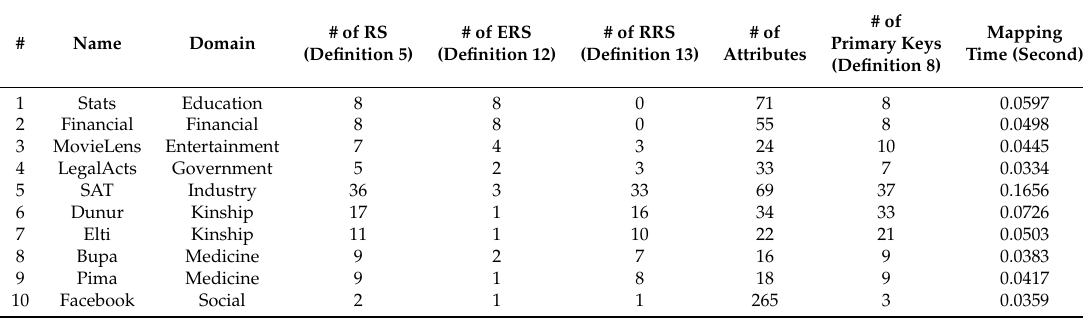
Table 4. 10 Real-World Relational Databases with Experiment Results for the Mapping